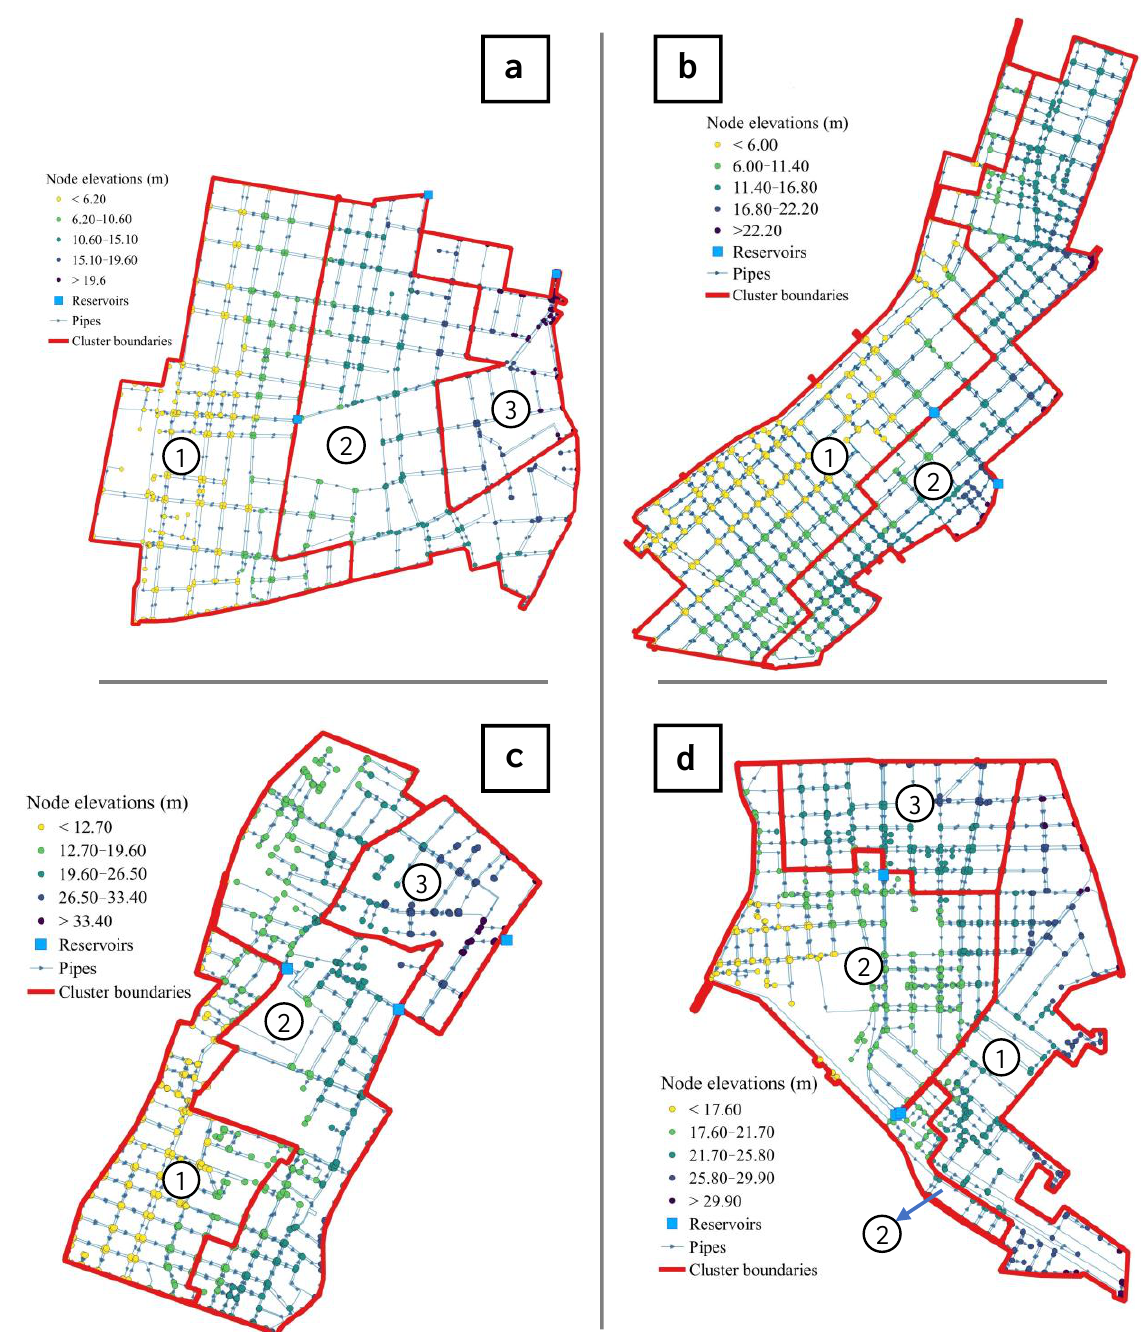
Figure 4. Clustering of original PMAs based on nodal altitudes: ( a ) Boud (three clusters), ( b ) Kentro (two clusters), ( c ) Panachaiki (three clusters), and ( d ) Prosfygika (three clusters). PMA locations are illustrated in Figure 1.